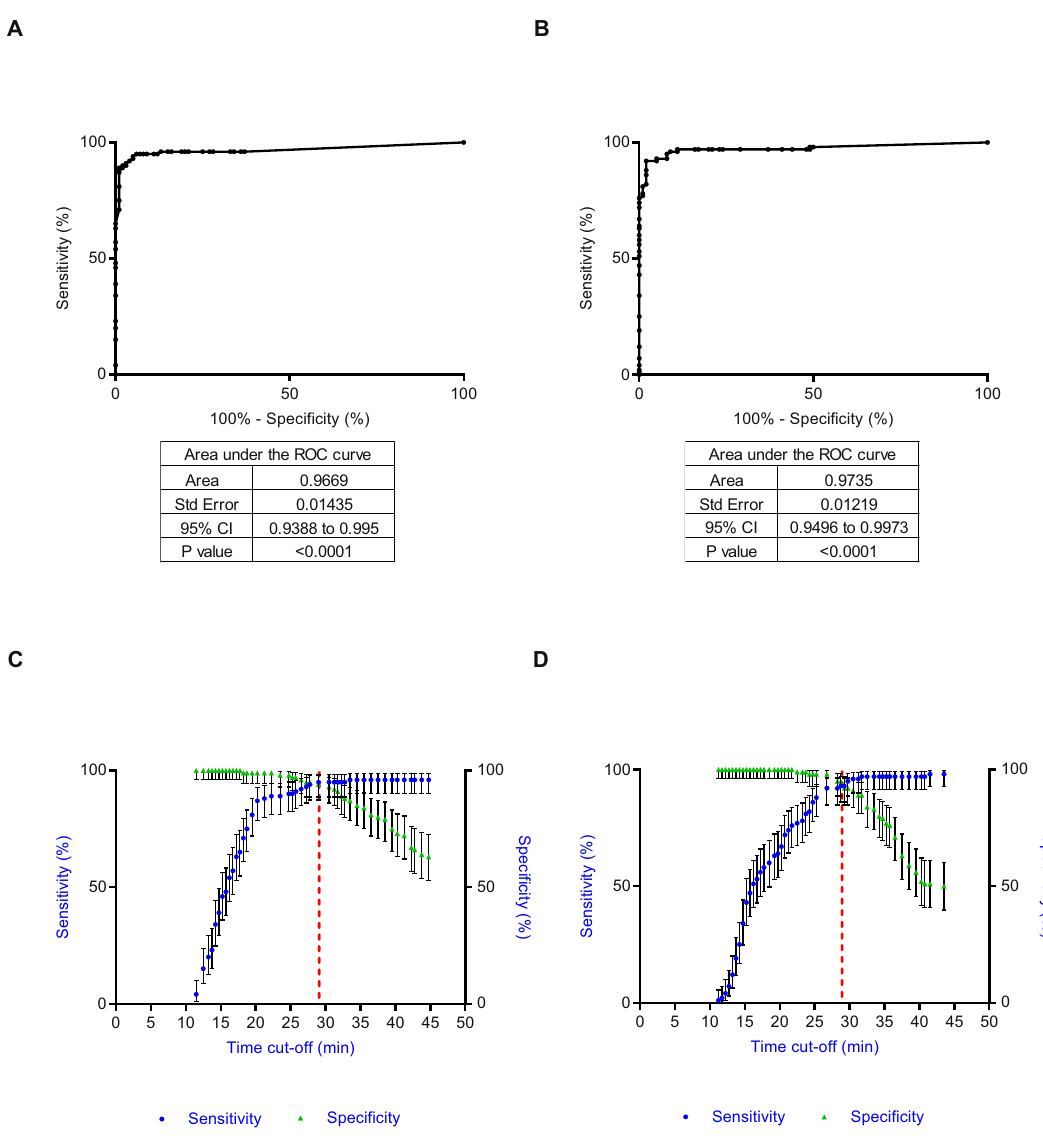
Fig. 2 ROC curves for LAMP assays. ROC curves were based on mean time to detection of 100 HCV positive and 100 HCV negative samples tested in a double-blind fashion. A , B ROC curve analysis, performed using the Clopper-Pearson Method (one-sided, no adjustments for multiple comparisons) for RT- LAMP and RNA samples (a) and for LAMP and cDNA samples ( B ). C , D Graphs showing sensitivity (circle) and speci fi city (triangle) at different time points in minutes for RT-LAMP ( C ) and LAMP ( D ). Error bars are 95% con fi dence intervals. The dashed line indicates the cut-off time in minutes, where sensitivity and speci fi city is optimal. Source data are provided as a Source data fi